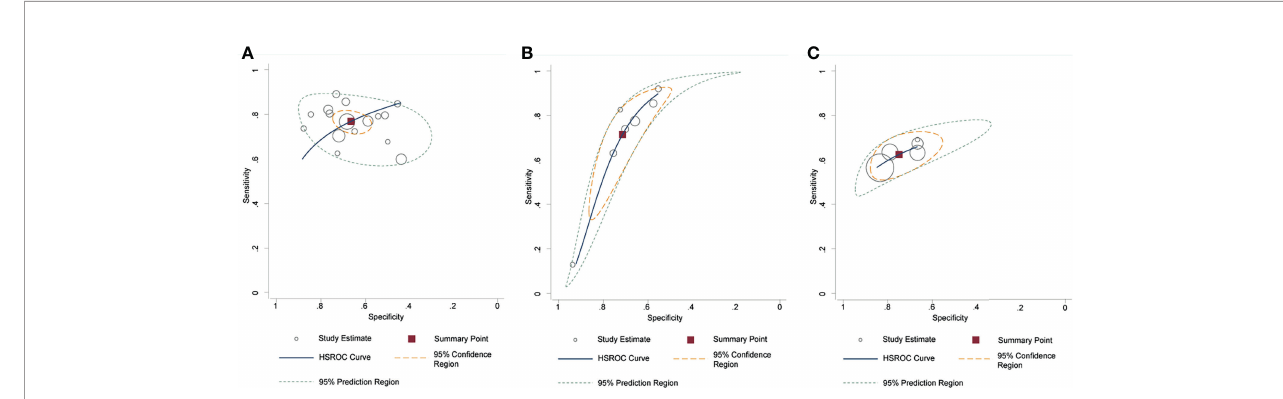
FIGURE 4 | Hierarchic summary receiver operating characteristic plots with summary point and 95% con fi dence area for the overall. (A) length of capsular contact; (B) apparent diffusion coef fi cient; (C) tumor